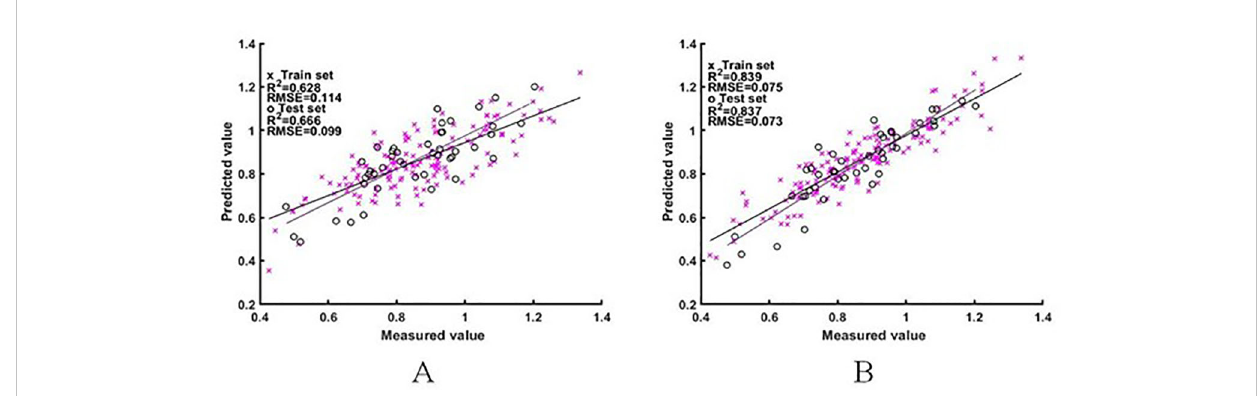
FIGURE 8 NNI estimation results based on log difference spectra [ (A) is the ELM model estimation result, (B) is the BES-ELM model estimation